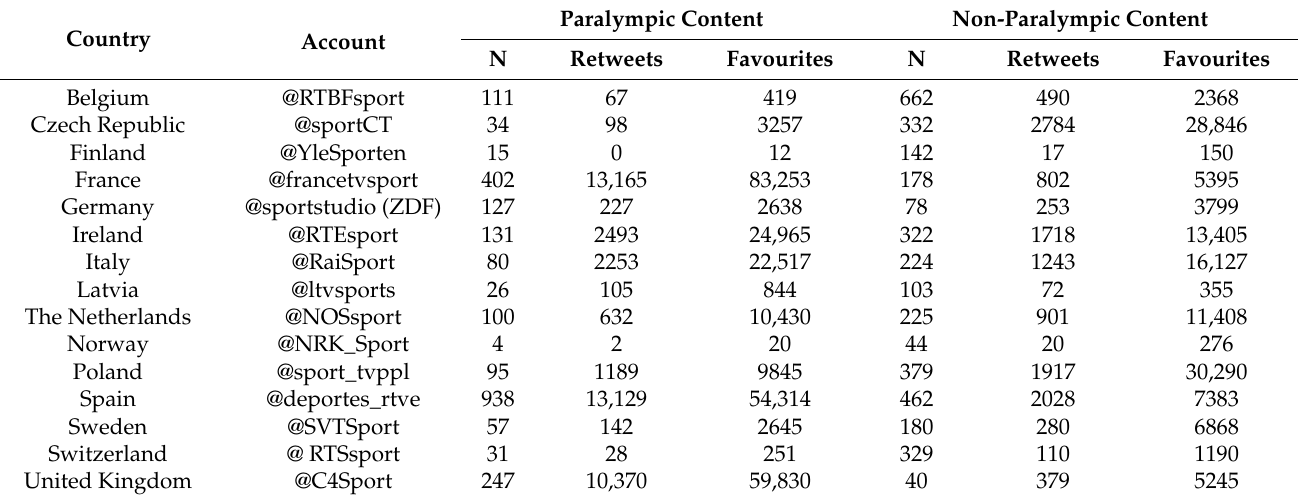
Table 3. Engagement figures obtained for Paralympic-content and non-Paralympic